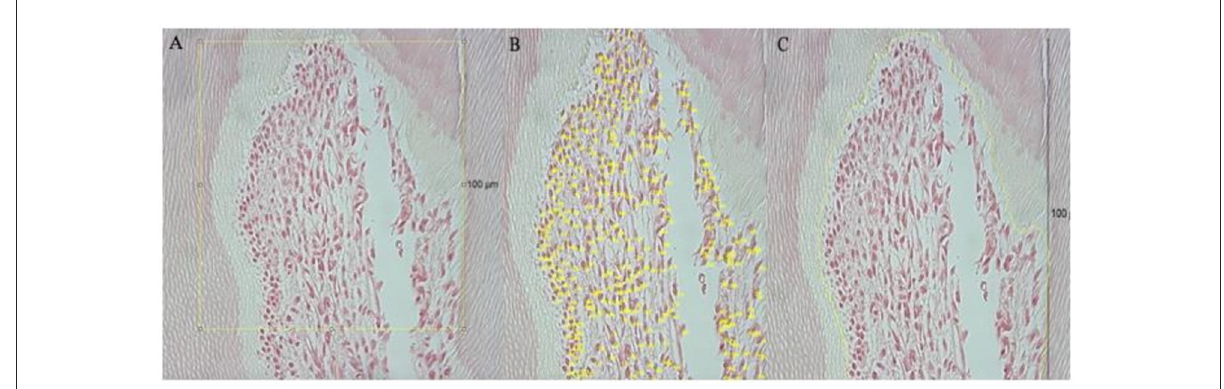
FIGURE2 Representative of the tools used in Image J. Yellow line represents the area that was measured and quantified; (A) shows the pulp region analyzed, based on the 100 µ m scale; in (B) it is possible to observe the manual counting of the cells; (C) shows how the area was measured, covering only the cells that were